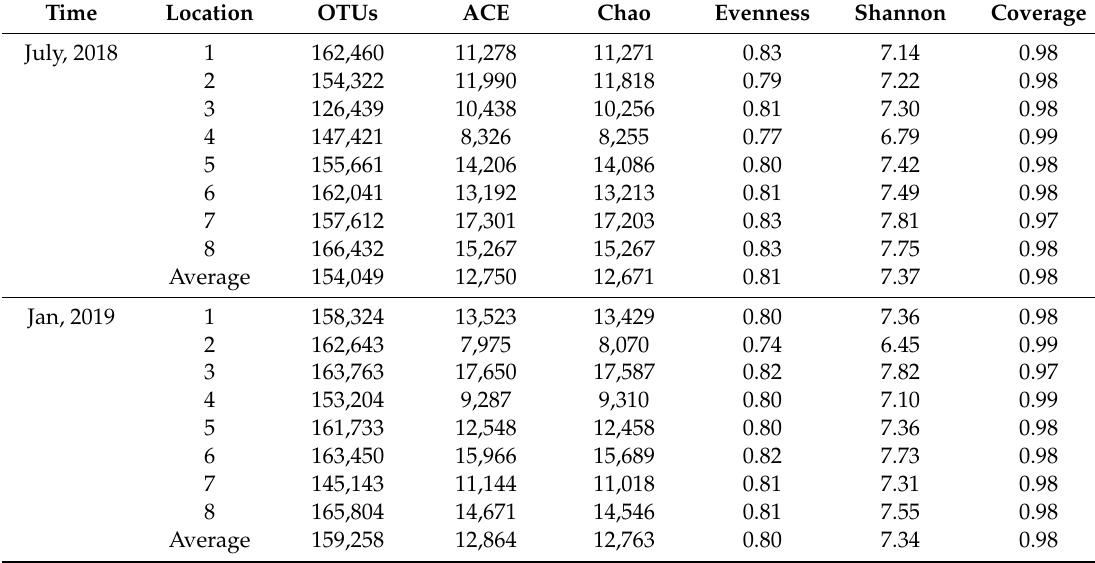
Table 2. Alpha diversity indicators of the soil bacteria at the di ff erent sampling